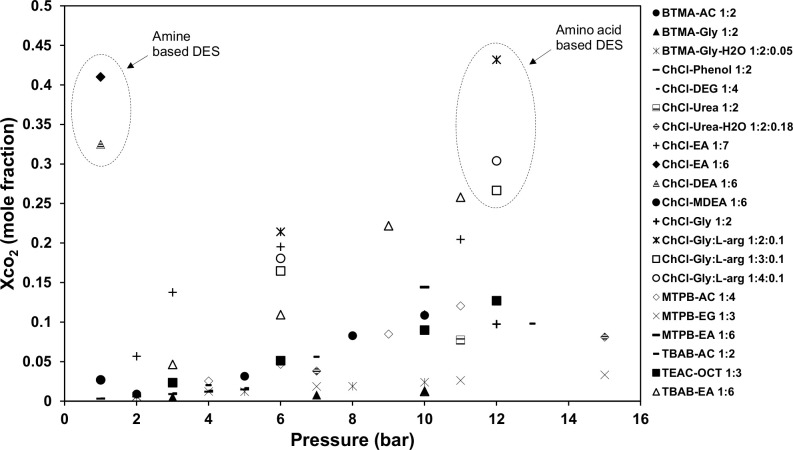
CO2 solubility in various DESs reported at temperature range from 298.15–313.15K.(●) Benzyl trimethylammonium chloride (BTMAC)+acetic acid (AC) (1:2) [11], (▲) BTMAC+glycerol (Gly) (1:2) [11], (Җ) BTMAC+Gly+H2O (1:2:0.05) [11], (−) Choline chloride (ChCl)+phenol (1:2) [19], (-) ChCl+diethylene glycol (DEG) (1:4) [11], (□) ChCl+urea (1:2) [15], (◊) ChCl+urea+H2O (1:2:0.18) [17], (+) ChCl+ethanolamine (EA) (1:7) [11], (♦) ChCl+EA (1:6) [21], (Δ) ChCl+diethanolamine (DEA) (1:6) [21], (○) ChCl+ Methyldiethanolamine (MDEA) (1:6) [21], (+) ChCl+Gly (1:2) [20], (Җ) ChCl+Gly+L-arginine (1:2:0.1) [22], (□) ChCl+Gly+L-arginine (1:3:0.1) [22], (○) ChCl+Gly+L-arginine (1:4:0.1) [22], (◊) Methyltriphenylphosphonium bromide (MTPB)+AC (1:4) [11], (X) MTPB+ethylene glycol (EG) (1:3) [11], (−) MTPB+EA (1:6) [11], (-) Tetrabutylammonium bromide (TBAB)+AC (1:2) [11], (■) Tetraethylammonium chloride (TEAC)+OCT (1:3) [11], (Δ) TBAB+EA (1:6) [11].